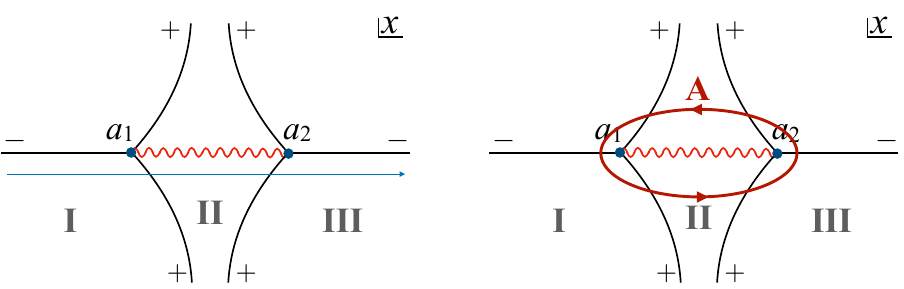
Figure 4 . The Stokes graph for harmonic oscillator. In order to obtain the quantization condition, we take the orbit from the left to the right below the real axis by taking into account the Stokes phenomena (Left panel). The cycle A is defined as an oriented cycle enclosing two turning points a 1 and a 2 (Right